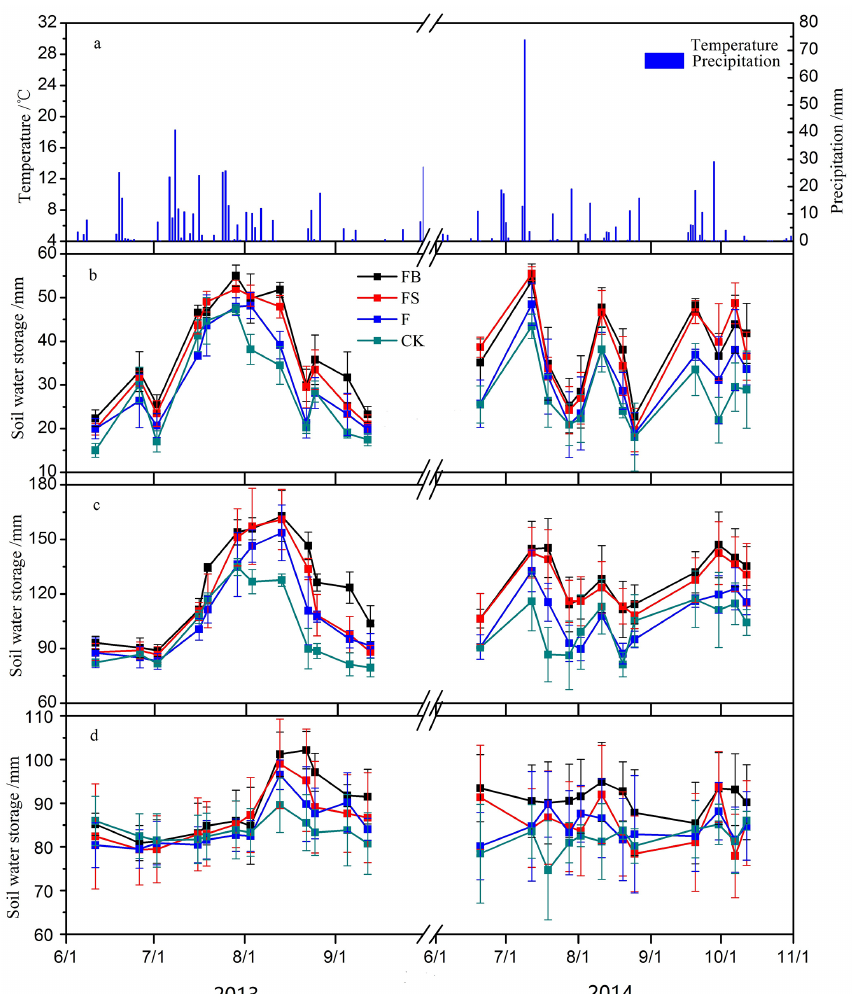
Figure 2. Temporal changes of (a) temperature and precipitation, (b) 0–20cm soil water storage, (c) 20–100cm soil water storage, and (d) 100–180cm soil water storage for fish-scale pits with branch mulching (FB), fish-scale pits with straw mulching (FS), fish-scale pits without mulching (F), and bare land treatment (CK). Error bars represent ± 1SD (1 standard